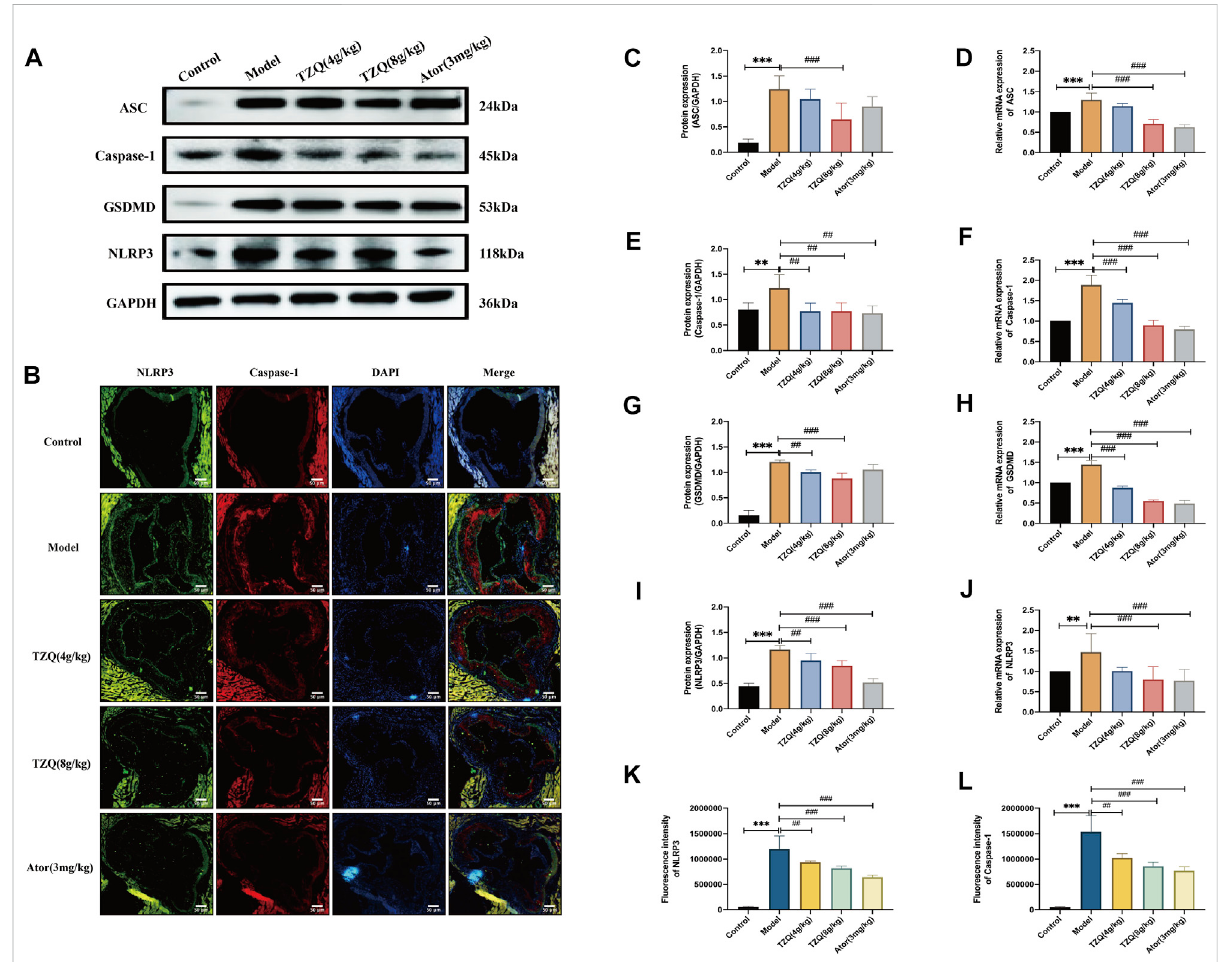
FIGURE 5 Effect of TZQ on pyroptosis. (A) : Western blot of pyroptosis-related proteins in the aortic root. (B) : Colocalization of Nod-like receptor protein 3 (NLRP3)/caspase-1 immuno fl uorescence in aortic root (×200). (C,E,G,I) : Quantitative analysis of gray values of bands from Western blots, GAPDH was used as loading control. (D,F,H,J) : Quantitative analysis of mRNA from RT-PCR. (C) : ASC. (D) : ASC mRNA. (E) : Caspase-1. (F) : Caspase-1 mRNA. (G) : Gasdermin protein family member D (GSDMD). (H) : GSDMD mRNA. (I) : NLRP3. (J) : NLRP3 mRNA. (K) : NLRP3 fl uorescence density. (L) : Caspase-1 fl uorescence density. Scale bar = 50 μ m, n = 4 mice for each group, ** p < 0.05, *** p < 0.01 versus Control, ## p < 0.05, ### p < 0.01 versus